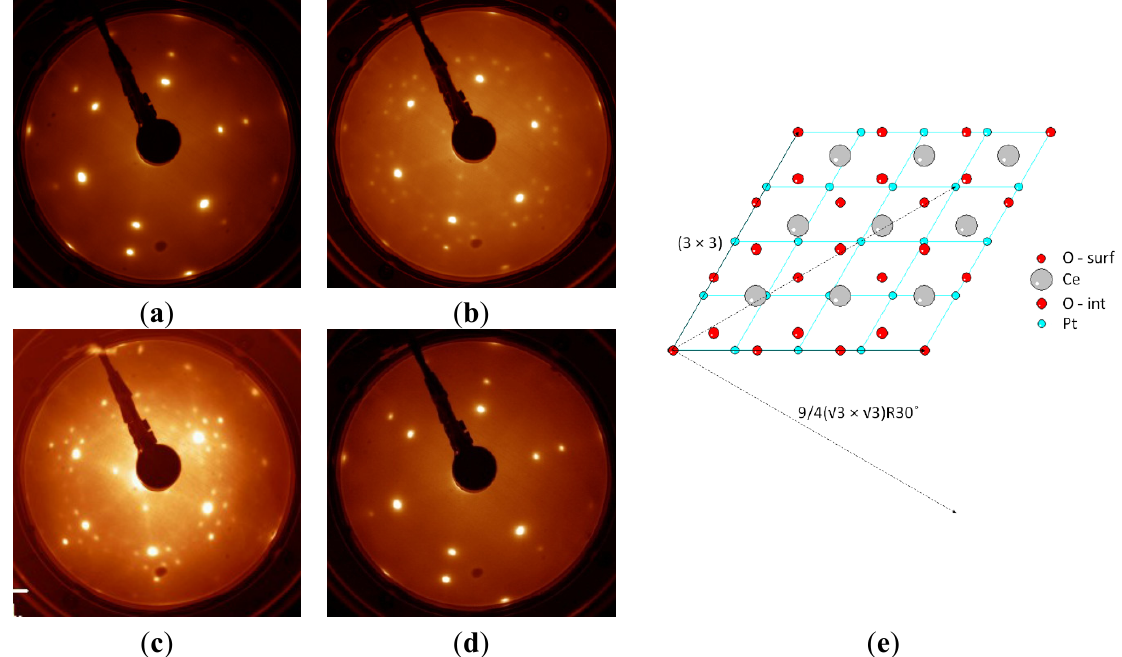
Figure 8. LEED patterns ( E = 80 eV) of a 2 ML cerium oxide film on Pt(111) ( a ) as prepared, ( b ) after intermediate reduction by heating in UHV at 770 K for 30 min (c Ce3+ ~ 40%, as measured by XPS), showing the (3 × 3) and 9/4( √3 × √3 )R30 phase ( c ) after strong reduction by heating in UHV at 1040 K for 15 min (c Ce3+ ~ 60%–80%) and showing the 9/4( √3 × √3 )R30 phase ( d ) after re-oxidation by heating in O 2 at 1040 K. ( e ) Model of the 3:4 coincidence cell at the interface between CeO 2 and Pt(111), showing evidence of the vectors of the (3 × 3) supercell (solid line) and of the 9/4( √3 × √3 )R30 supercell (dashed lines), which coincide with specific atoms in the coincidence cell. Atoms labeled by O-surf and O-int represent surface and interface oxygen layers, respectively. Adapted from Ref [7] with permission from the PCCP Owner Societies.